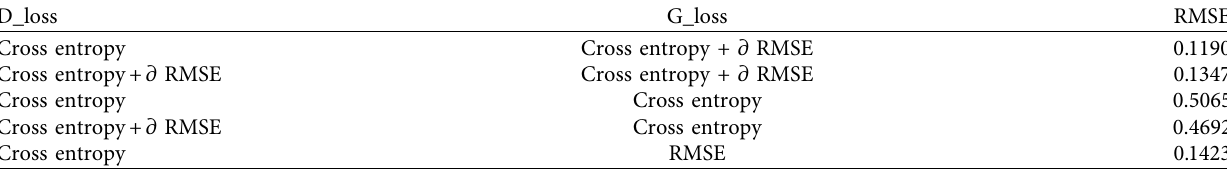
Table 3: The influence of the loss function on model